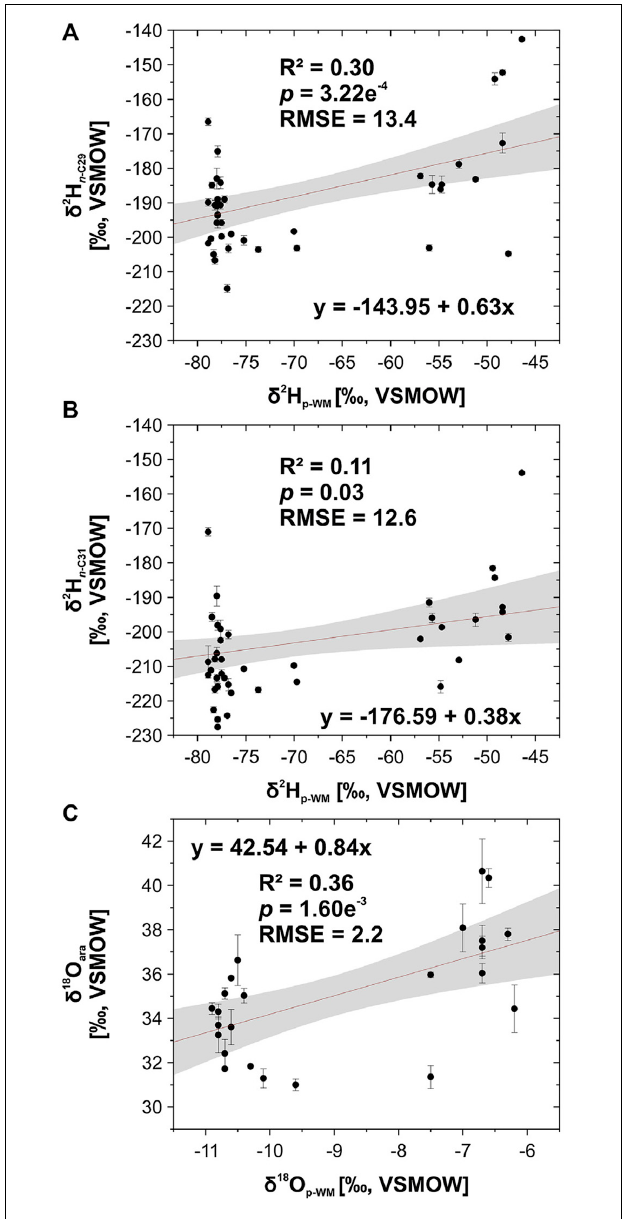
FIGURE 3 | δ 2 H signatures of the leaf wax-derived n -alkanes (A) n -C 29 and (B) n -C 31 , as well as (C) δ 18 O ara signatures from the topsoil transect through Mongolia plotted against the amount-weighted δ 2 H and δ 18 O signature of precipitation ( δ 2 H p - WM / δ 18 O p - WM ). Red trend lines illustrate linear regressions, gray shaded areas the 95% confidence interval. Bold R 2 / p -values indicate the level of significance ( α = 0.05).